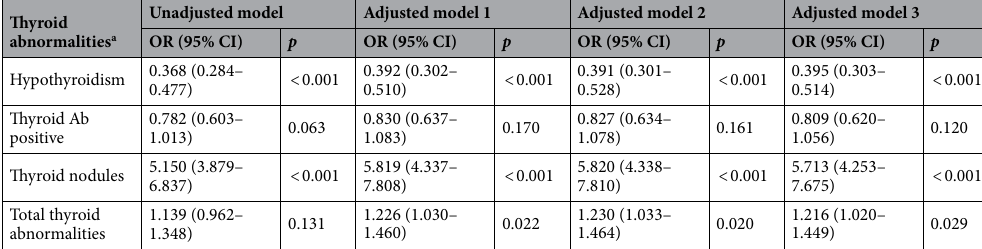
Table 2. Risk of thyroid abnormalities in adults, unadjusted and adjusted for potential confounders. Model 1: Adjusted for age, gender, education, and income. Model 2: Adjusted for age, gender, education, income, and smoking cigarettes. Model 3: Adjusted for age, gender, education, income, smoking cigarettes, metabolic syndrome, and hyperuricemia. a For the independent variable of region, the inland was used as the reference